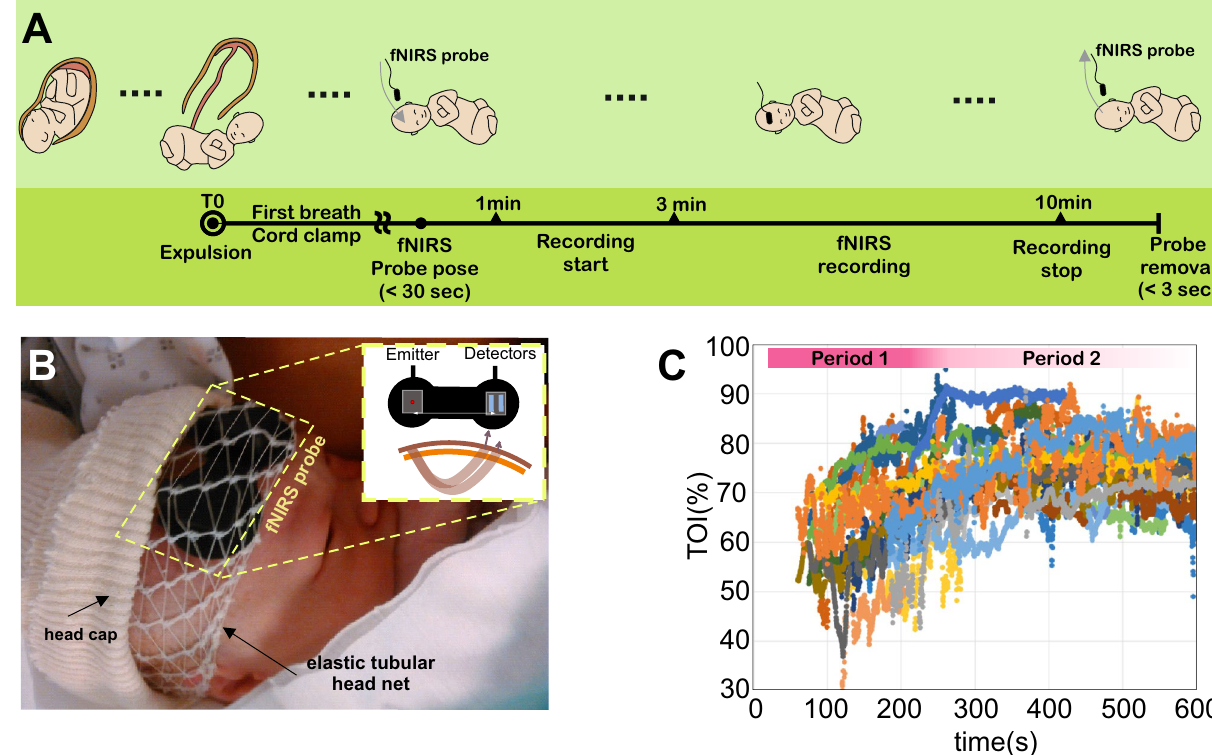
Figure 1. Recording procedures. ( A ) Experimental protocol. ( B ) Set-up for positioning the NIRS probe on the forehead of the newborn. ( C ) Raw TOI data corresponding to all subjects.